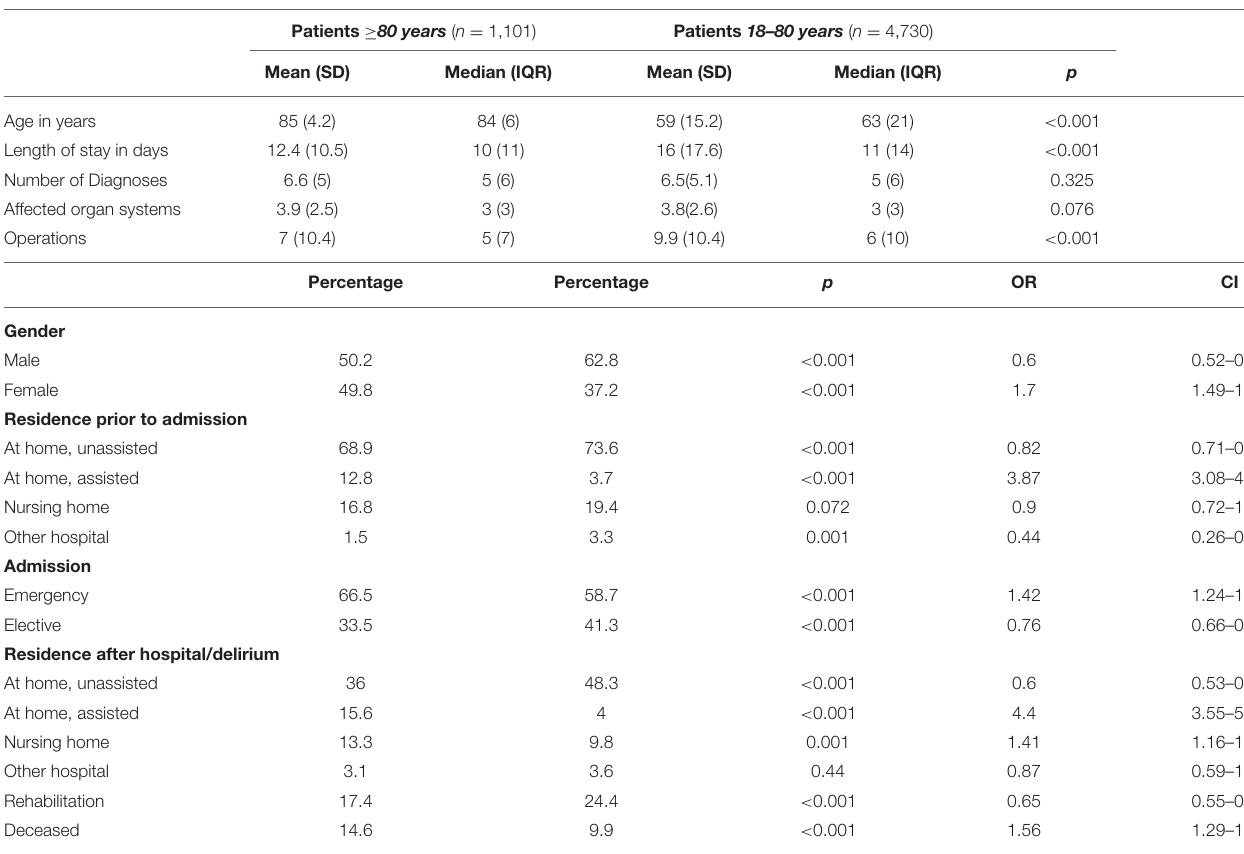
TABLE 2 | Sociodemographic and medical characteristics of delirious patients.